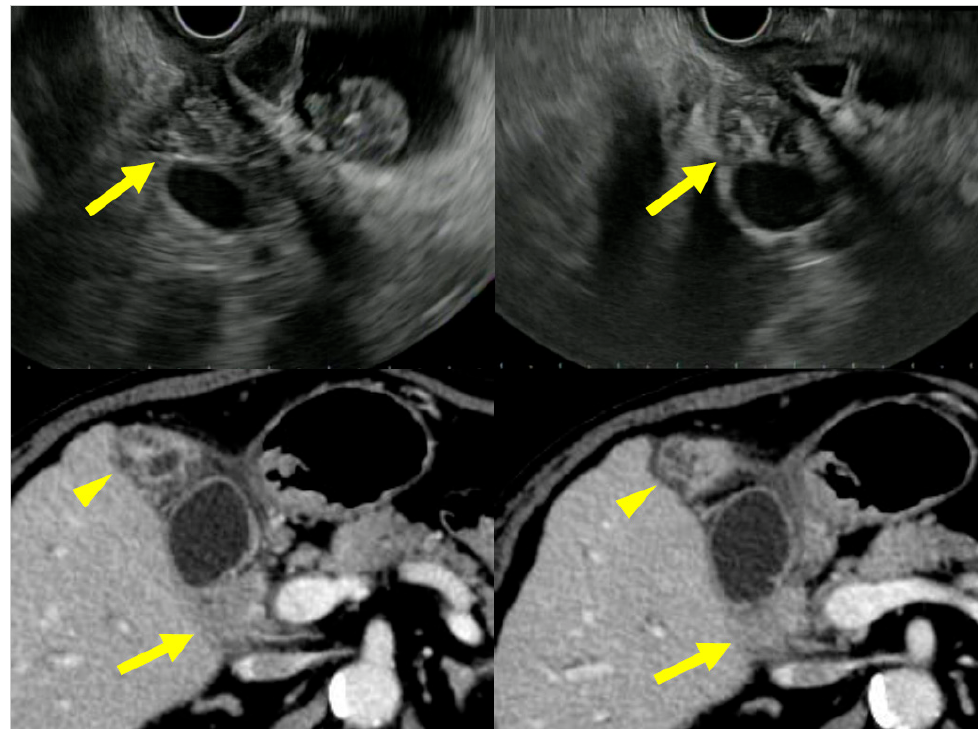
Figure 9. US (protruding type B’) and CT (protruding type B) findings of a case with a localized type of IgG4-sclerosing cholecystitis (arrows). The lesion at the fundus (arrowheads) was a true ADM lesion because this lesion had not changed at all after PSL treatment although a localized IgG4-CC lesion at the neck evidenced by biopsy had clearly improved. Diagnostics 2021 , 11 , x FOR PEER REVIEW